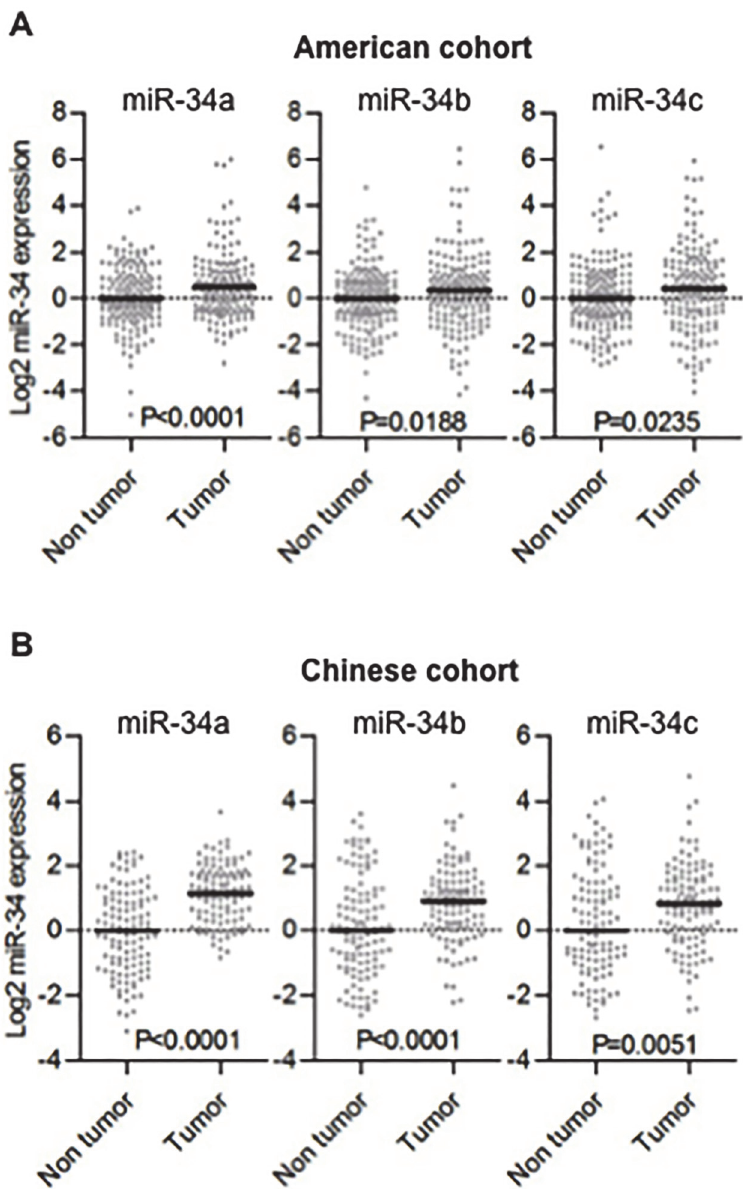
Fig 1. The miR-34 family members significantly increase in colon tumors compared to adjacent non- tumor tissues. (A, B) Dot plots represent miR-34a/b/c threshold cycle values from TaqMan qRT-PCR normalized to U66 in American cohort (A) and Chinese cohort (B). Horizontal bars indicate median expression value. Wilcoxon matched-pairs test was used. MiR-34a was not detectable in one patient and this patient was excluded from all